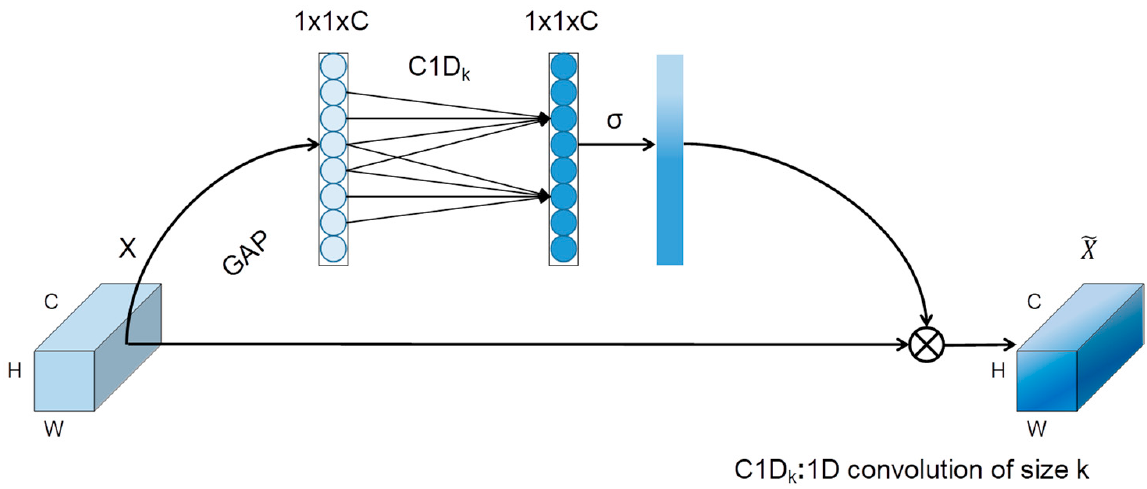
Figure 2. E ffi cient channel a tt ention module ECA. Figure 2. Efficient channel attention module